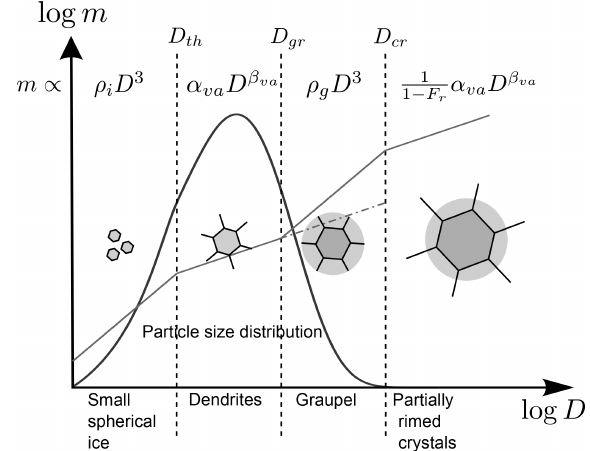
Figure 1. Summary of the mechanism used in the single-category scheme with an exemplary particle size distribution. ρ i is the den- sity of ice, α va and β va are empirical constants, ρ g is the diagnosed graupel density, and F r = q rim /q i is the rime fraction. The dashed– dotted line between D gr and D cr visualizes the extrapolation of the dendritic particles to the rimed regime for the calculation of ρ g ref- erenced in the